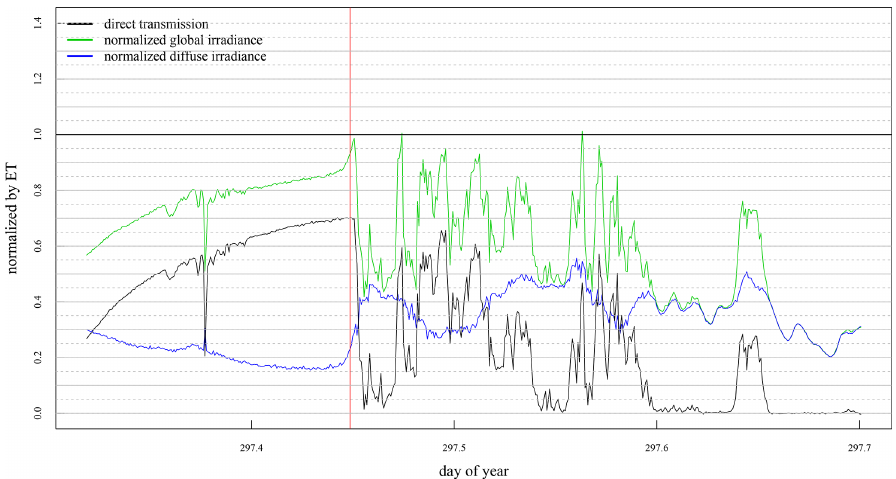
Figure 8. A plot of the direct normal transmission and the normalized global and diffuse irradiances near 500nm for 24 October 2009 at the ARM site in northern Oklahoma. The vertical red line marks the time of the measured spectra in Fig. 7. The direct transmission appears unaffected by nearby clouds, but the normalized diffuse irradiance and, therefore, the normalized global diffuse irradiance are enhanced over the clear-sky values, which explain the effect of apparent normalized global irradiance greater than 100% in Fig.